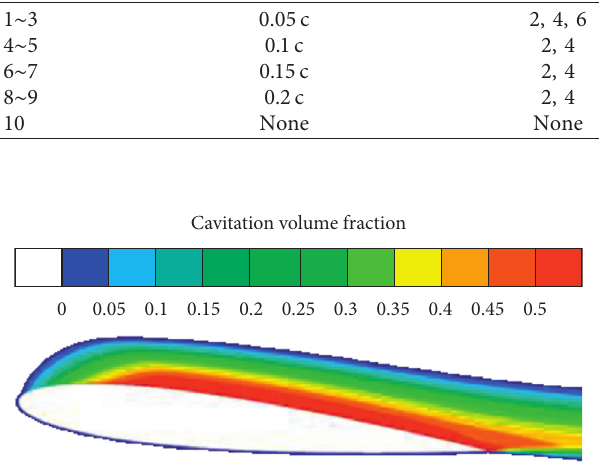
Figure 3: Cavitation nephogram without the influence of